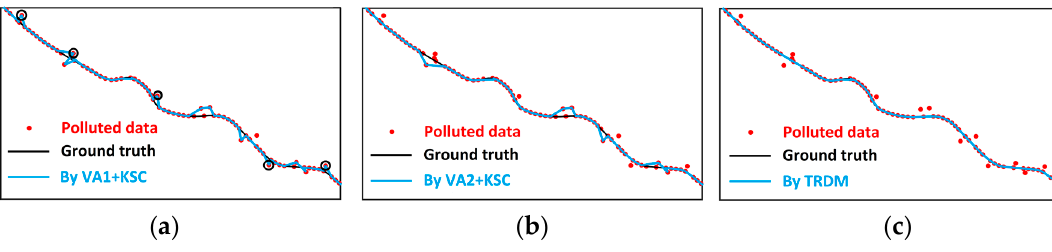
Figure 10. Comparison of outlier detection by VA + KSC and TRDM methods. ( a ) VA1 + KSC; ( b ) VA2 + KSC; ( c ) TRDM method.